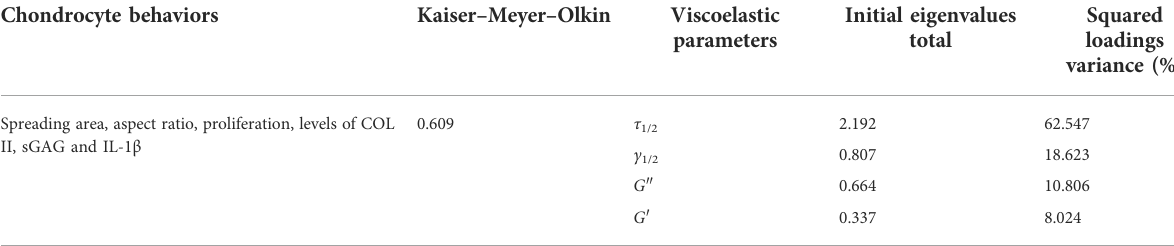
TABLE 1 Total variance explained by principal component analysis. Chondrocyte behaviors